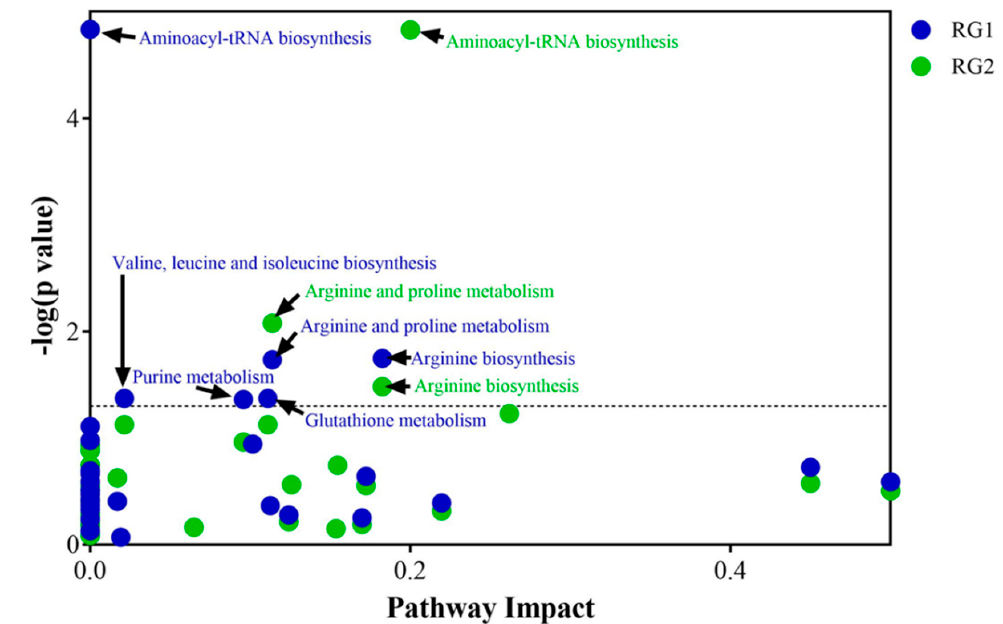
Figure 10. Pathway impact analysis of inoculated spinach. Statistically significant ( p -value ≤ 0.05) pathways that were impacted by RG1 strains (blue dot points) and pathways impacted by RG2 strains (green dot points) have been indicated with black arrows.